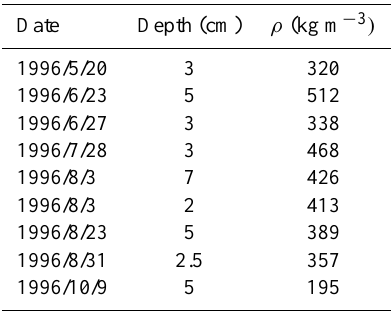
Table 1. Surface snow density at Yala glacier